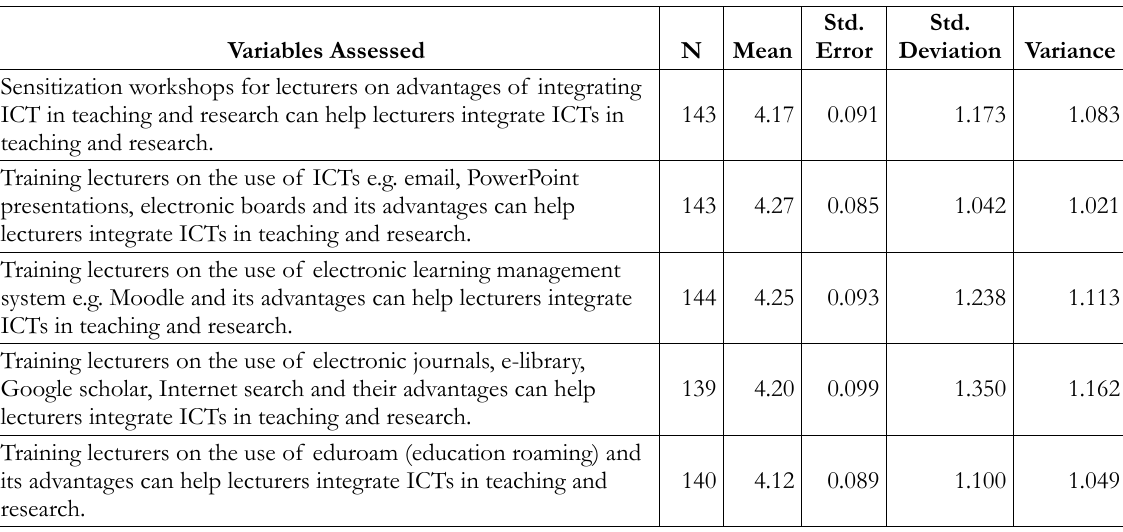
Table 4. Sensitization and training of lecturers in use of ICTs in teaching and research